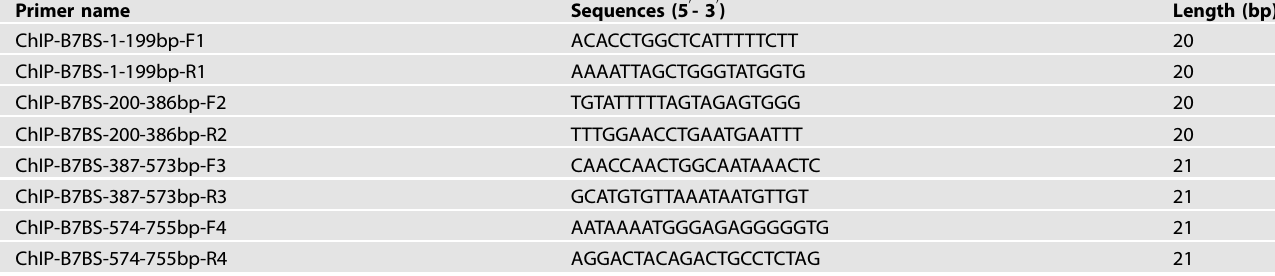
Table 2. The primers sequences for ChIP